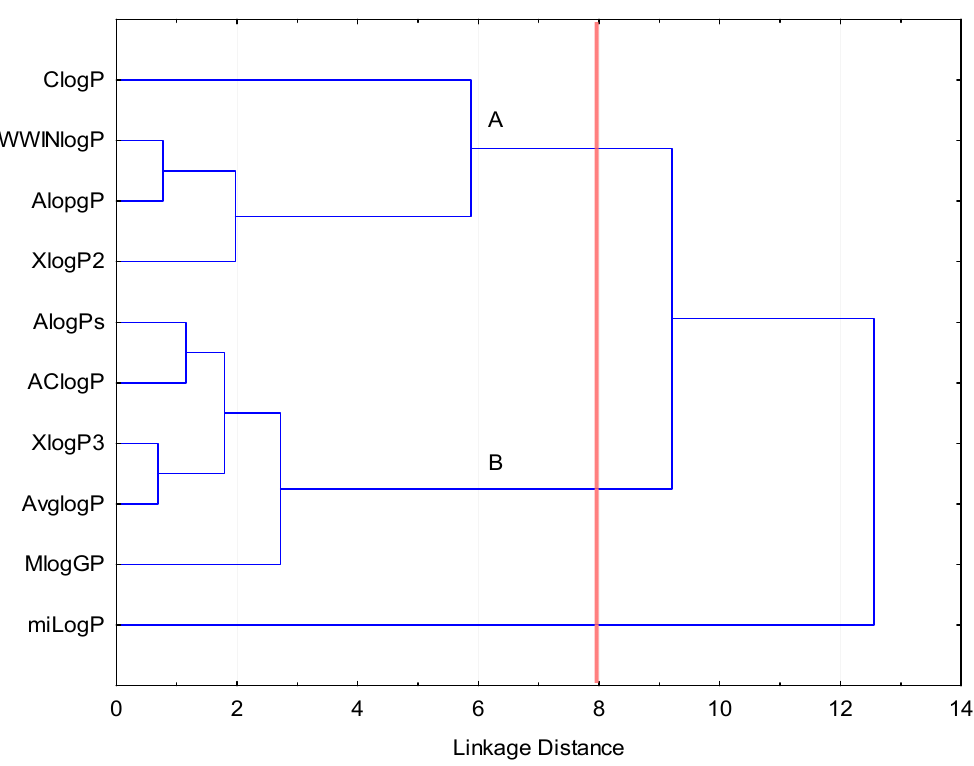
Figure 1. Results of cluster analysis (HCA) analysis of in silico estimated log P values. At eight distance units two clusters of interest can be observed ( A and B ), and one outlier ( miLog P ).